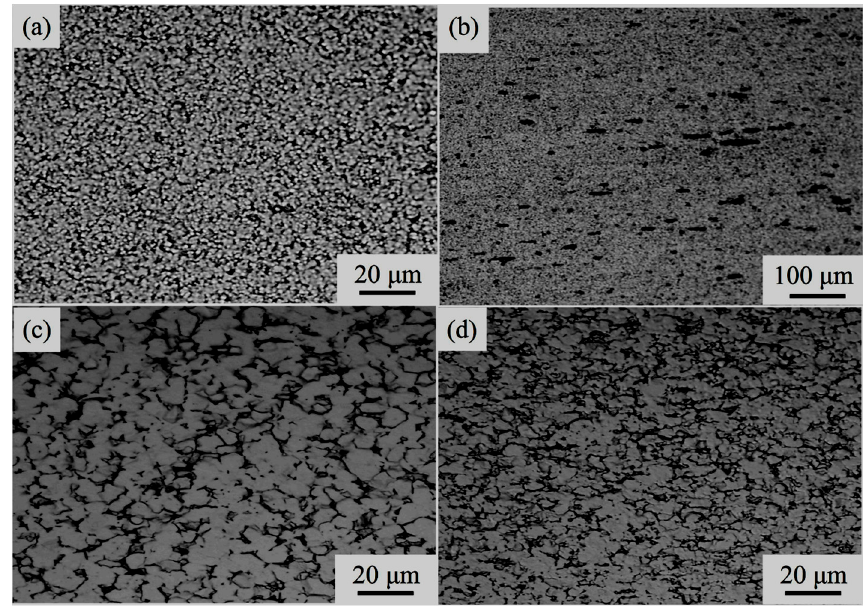
Figure 7. Optical micrographs of Ti-6Al-4V alloy after superplastic tensile deformation at the temperatures of 973 and 1123 K; ( a ) (cid:2013)(cid:4662) = 10 − 3 s − 1 and ( b ) (cid:2013)(cid:4662) = 5 × 10 − 3 s − 1 (973 K); ( c ) (cid:2013)(cid:4662) = 10 − 3 s − 1 and ( d ) (cid:2013)(cid:4662) = 5 × 10 − 3 s − 1 (1123 K).